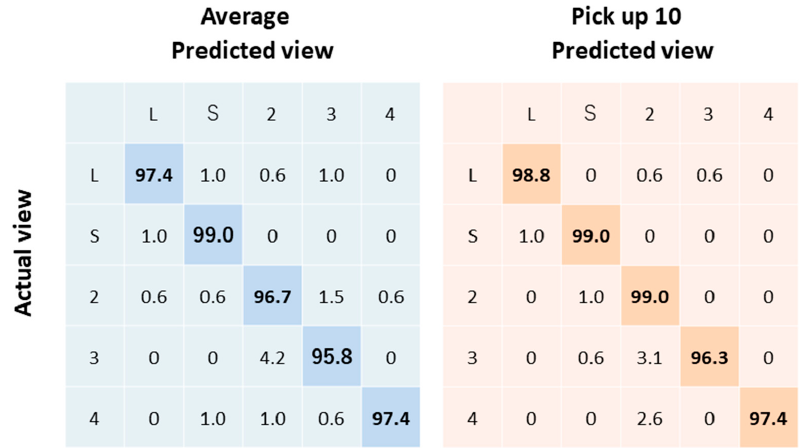
Figure 3. Echocardiogram view classification by deep-learning model: Actual view labels are on the y -axis, and neural network-predicted view labels are on the x -axis by view category for video classification.